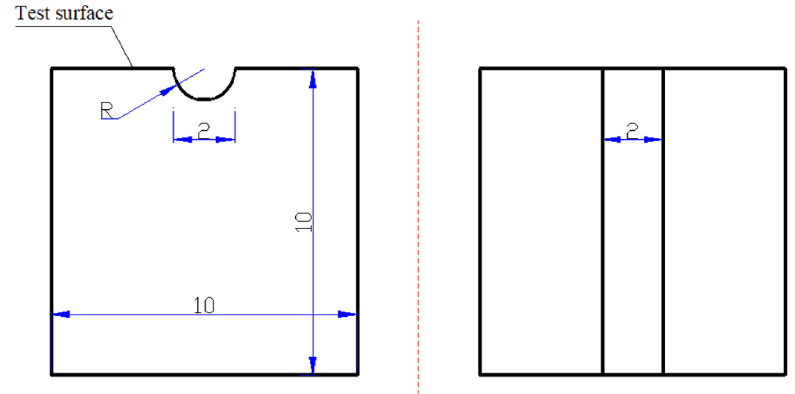
Figure 2. Specification of ADP: left: side view, right: top view, unit: mm.